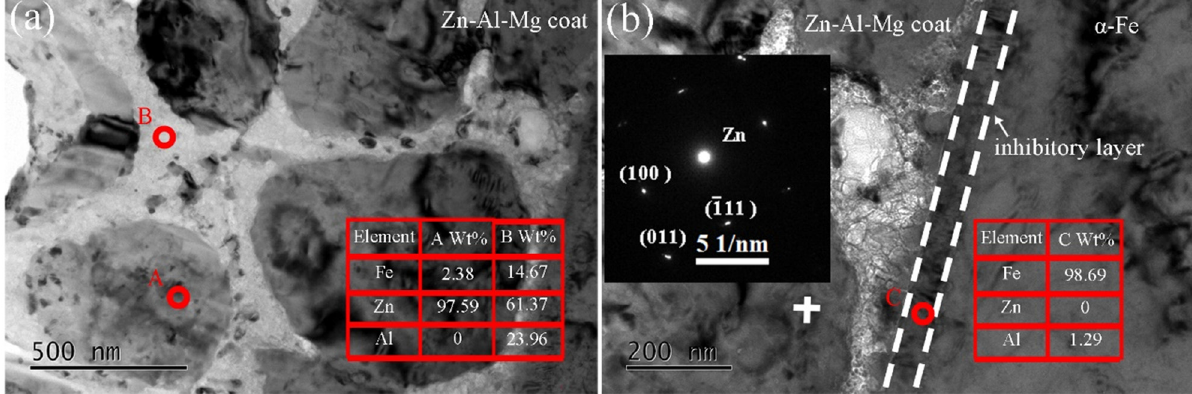
Figure 8: TEM images of BM coating: ( a ) Zn – Al – Mg coating ( b ) coating - steel